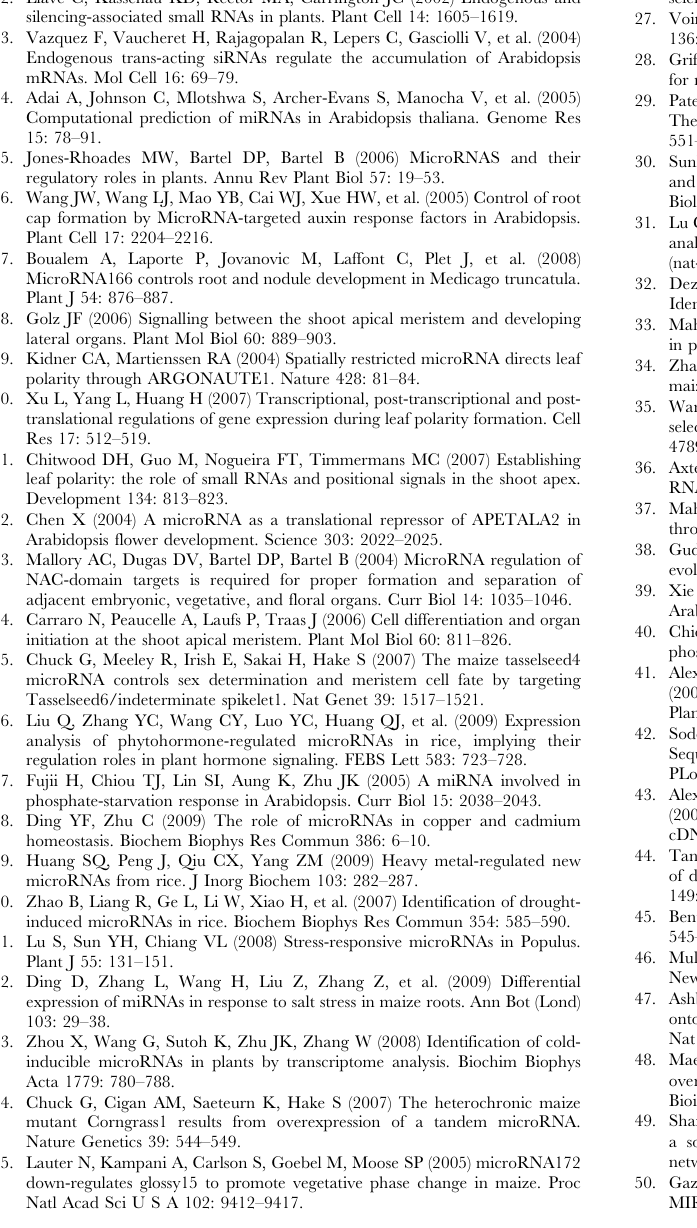
Table S10 Panzea accession of maize miRNA genes.